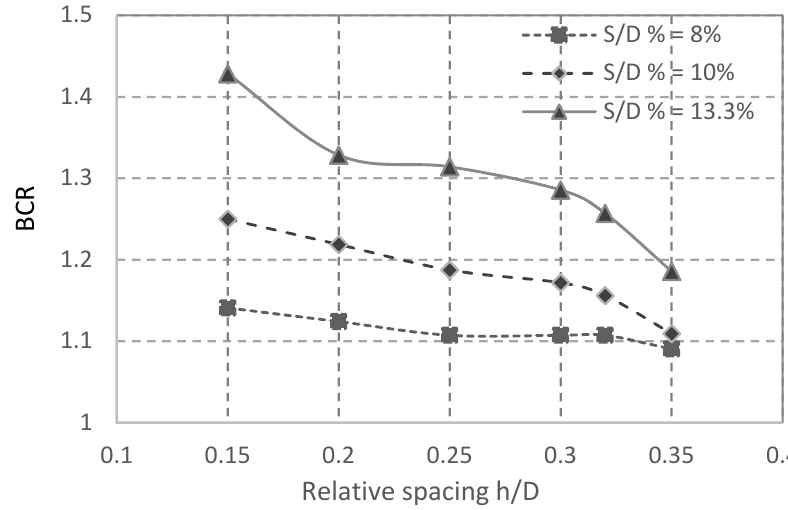
Figure 7. BCR decreased as the spacing between geogrid layer (h/D) increased.